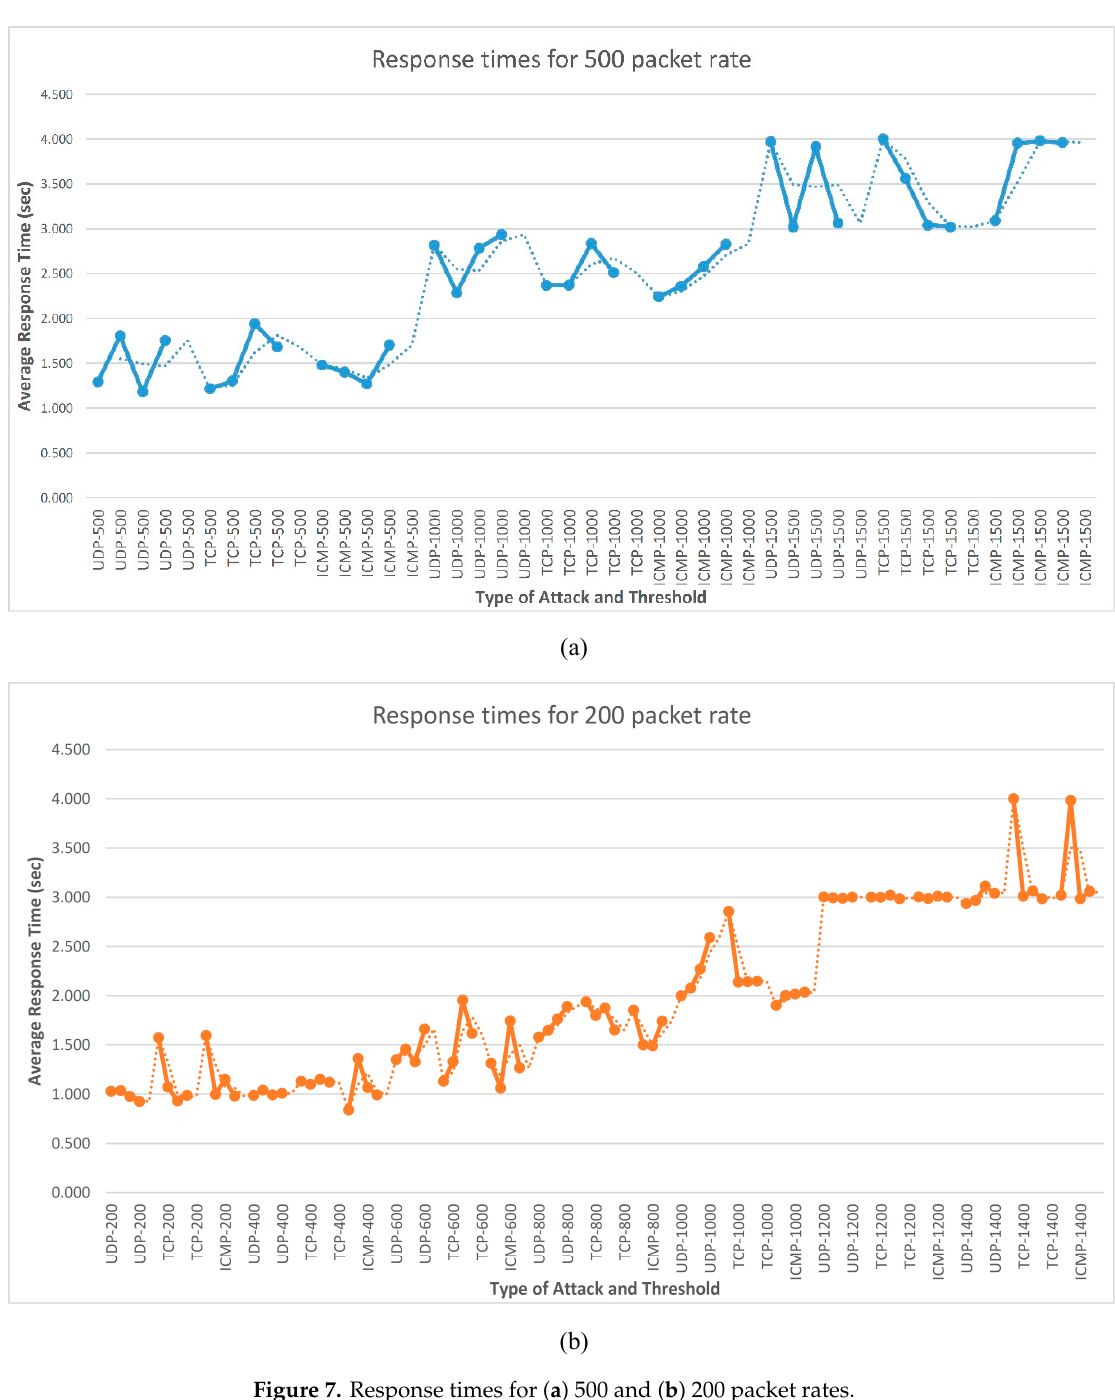
Figure 7. Response times for ( a ) 500 and ( b ) 200 packet rates.